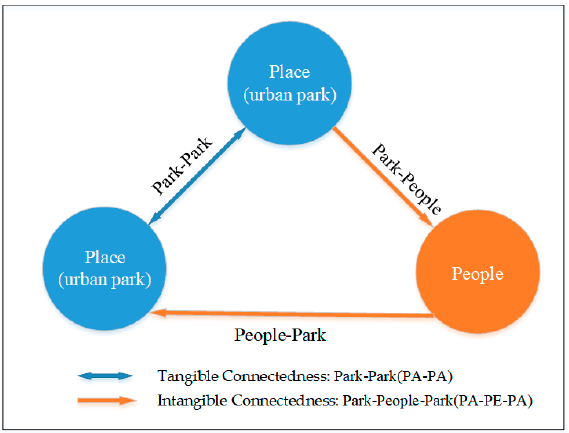
Figure 8. Relationships between two connectedness paths among urban parks.